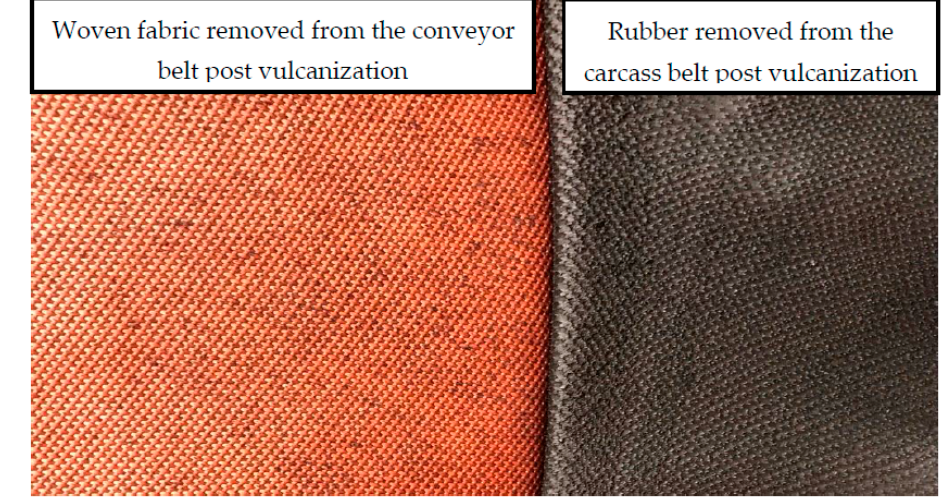
Figure 14. Woven fabric ply and rubber removed from the conveyor belt reinforcement.